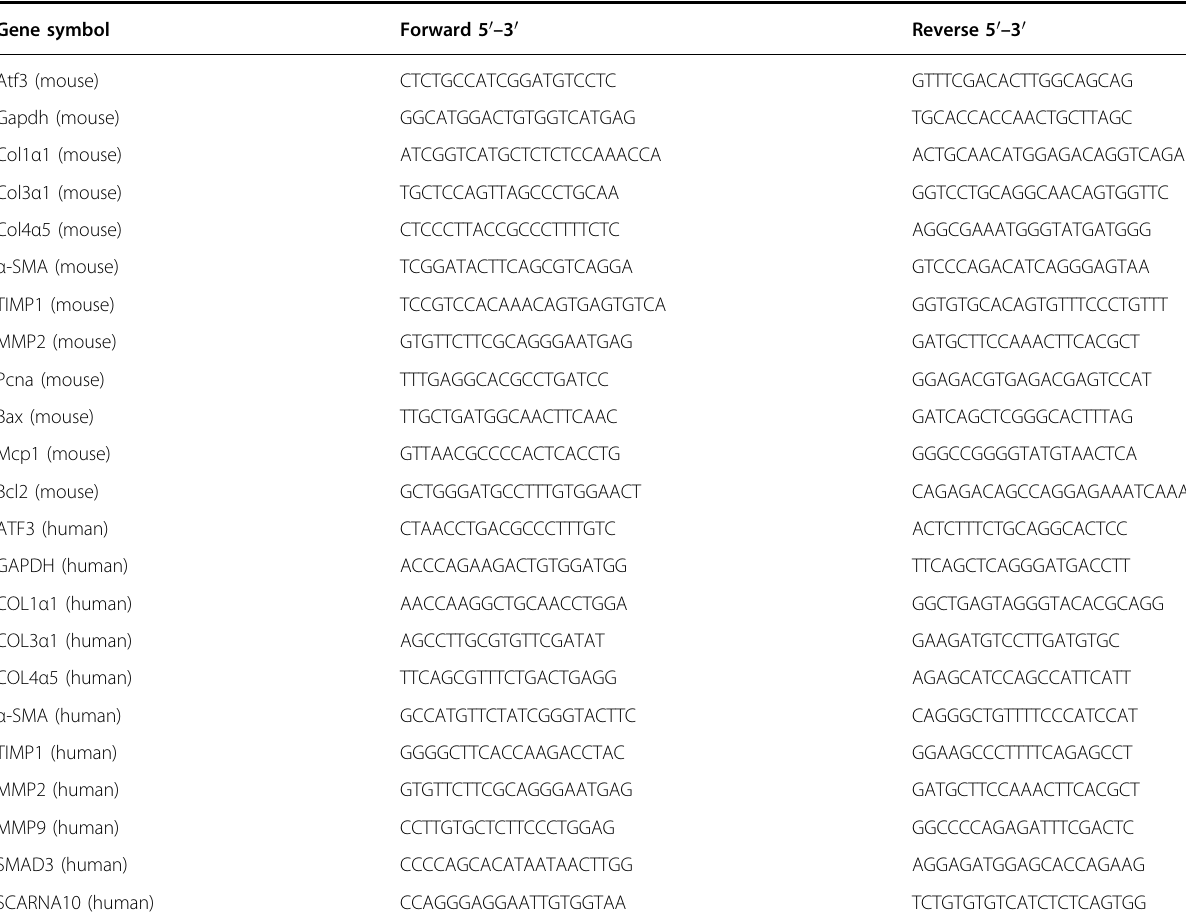
Table 3 qRT-PCR primers for analysis of transcript